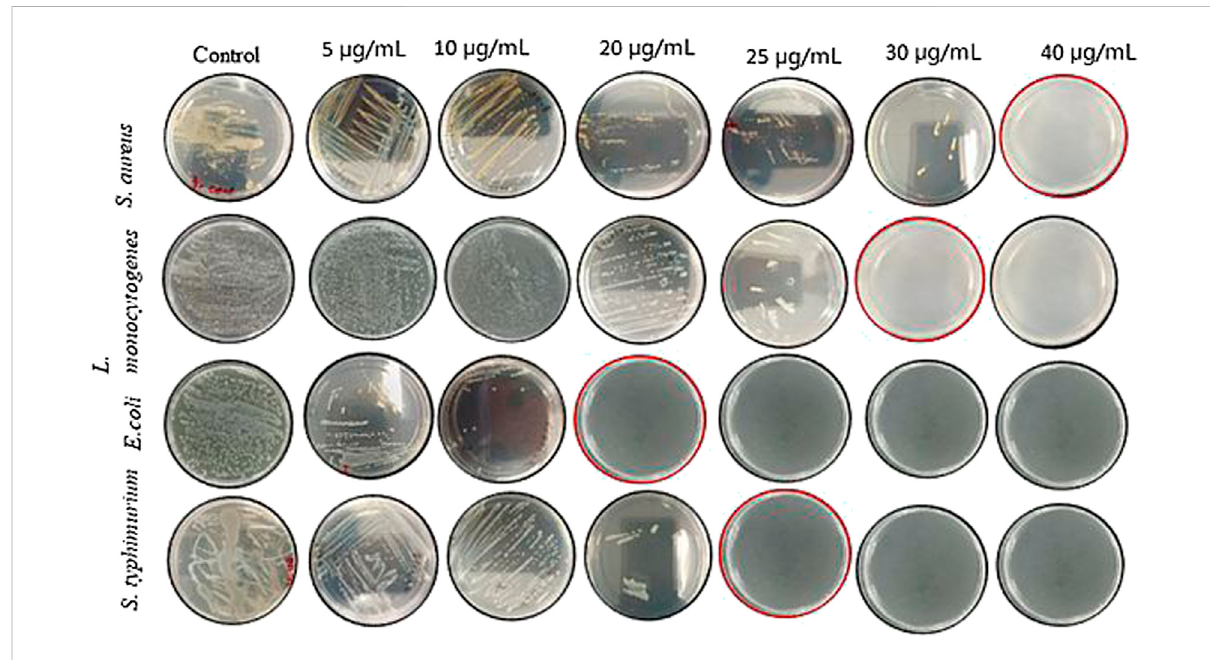
FIGURE 9 Minimum bactericidal concentration (MBC) of Rn- AgNPs against different bacterial strains. Plates with red margins show the MBC value for each bacterial